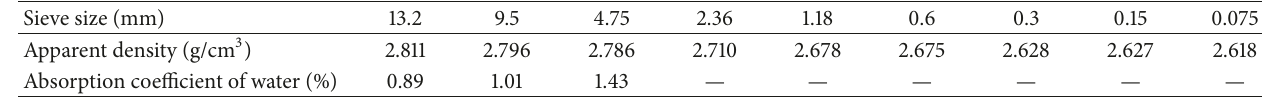
Table 3: Properties of aggregate.